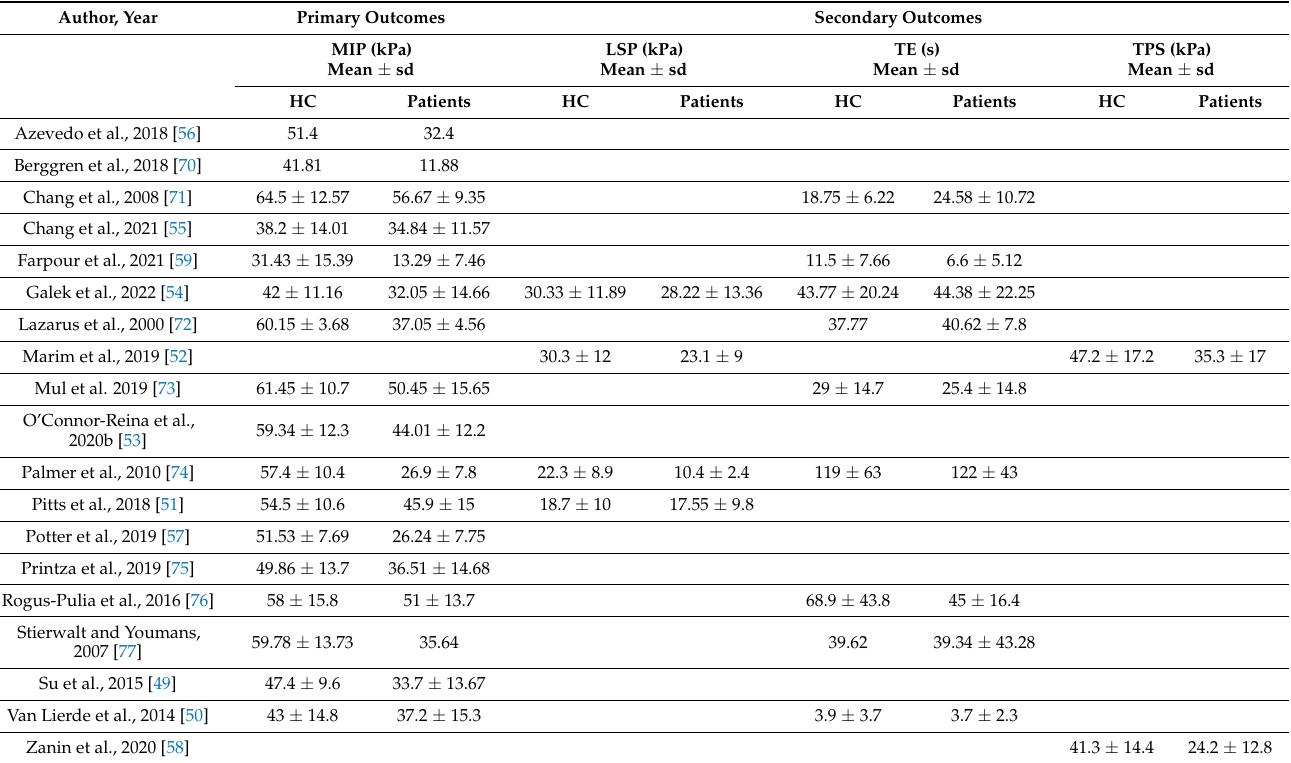
Table 6. IOPI measures for the case-control